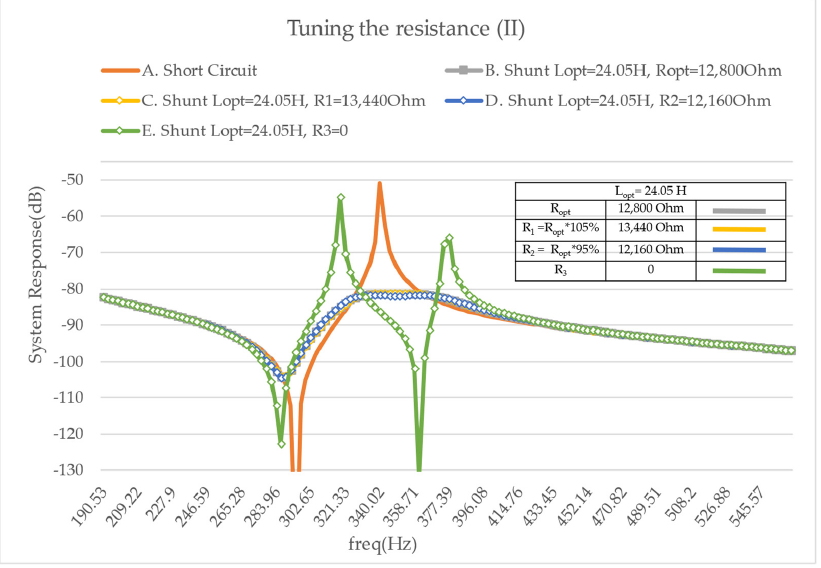
Figure 8. FRF Modulus on mode 2 — tuning the resistance — A. with a short circuit, B. with the optimal resistance and inductance, C. with twice the optimal resistance, D. with half of the optimal resistance, E. with the optimal inductance and no resistance. The short circuit and under—, optimal—, and overdamped cases are repeated from Figure 7 for